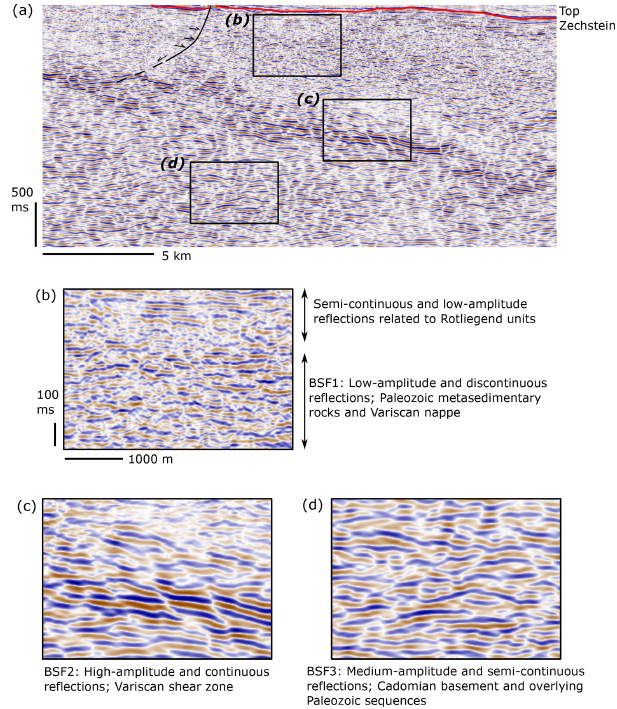
Figure 4. Basement seismic facies (BSF) described along the FRANKEN seismic survey. Panel (a) shows the SE portion of FRANKEN-1804 below the Top Zechstein horizon. (b) Low- amplitude and discontinuous reflections of BSF1 interpreted as Pa- leozoic metasedimentary rocks and Variscan nappe units. (c) BSF2 shows high-amplitude, continuous, and dipping reflections inter- preted as Variscan shear zones. (d) Medium-amplitude and semi- continuous reflections of BSF3 below the Variscan shear zone re- lated to the Cadomian basement and Paleozoic inner shelf facies not involved in Variscan